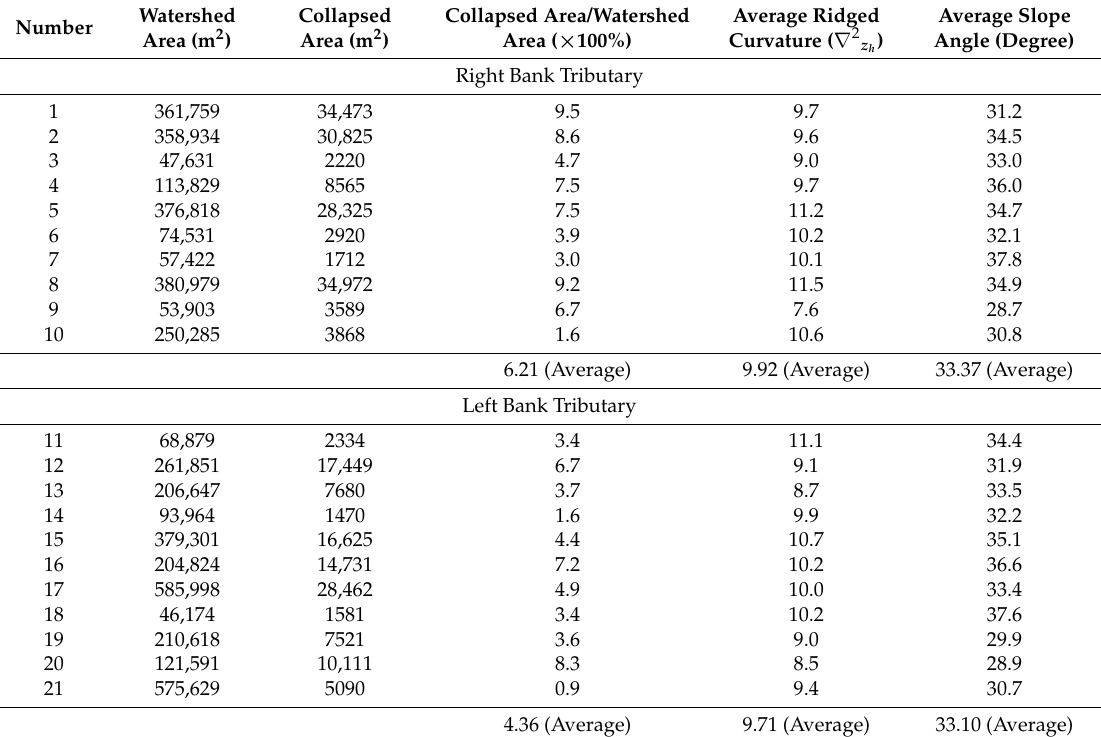
Table 1. Statistical data of 21 tributaries (the tributary number is the same in Figure